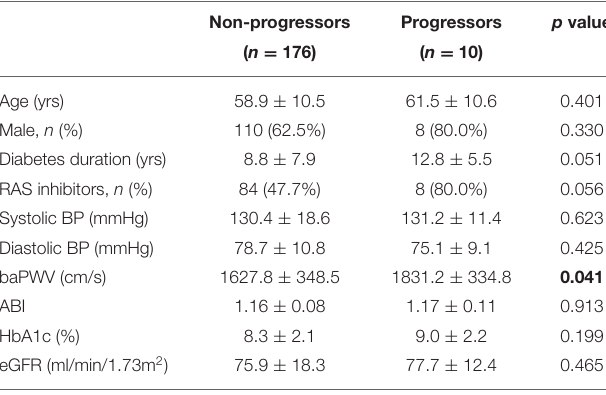
TABLE 3 | Characteristics according to progressors and non-progressors regarding albuminuria.